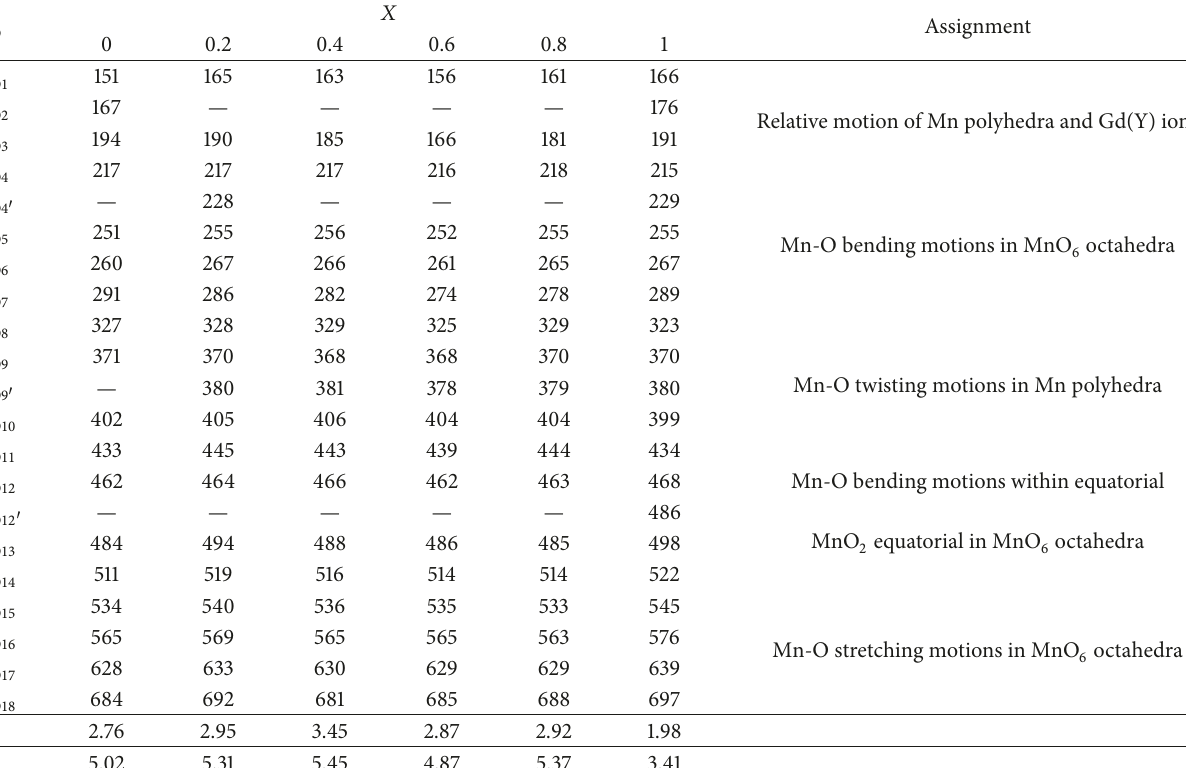
Table 2: Phonon-fit values of transverse optical mode 𝜔 TO (given in cm −1 ) of the IR reflectivity spectra of Gd 1−𝑥 Y 𝑥 Mn 2 O 5 with 𝑥 = 0, 0.2, 0.4, 0.6, 0.8, and 1 at room temperature.